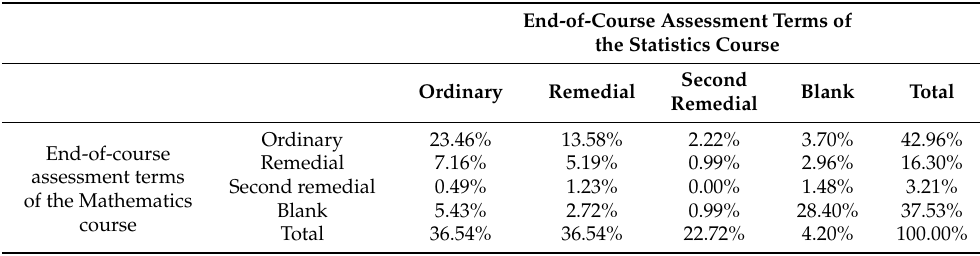
Table 5. The success rate of the students on the three possible end-of-course assessment terms.